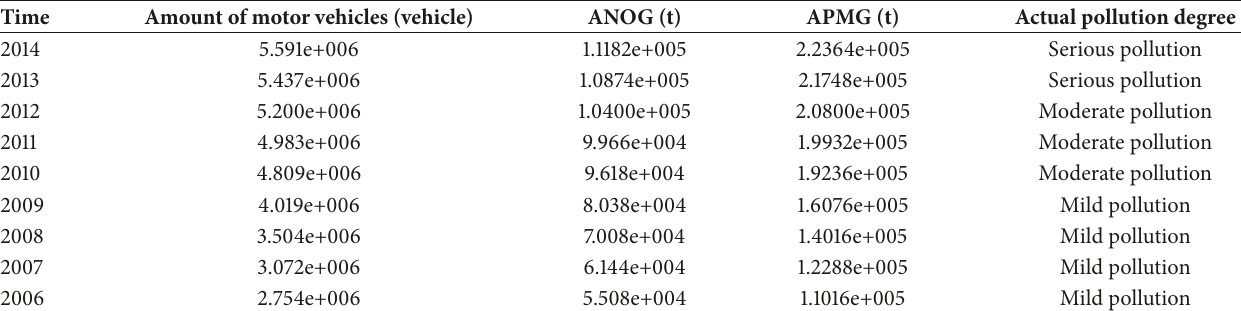
Table 7: Estimated values of pollution degree of NOx and PMx in